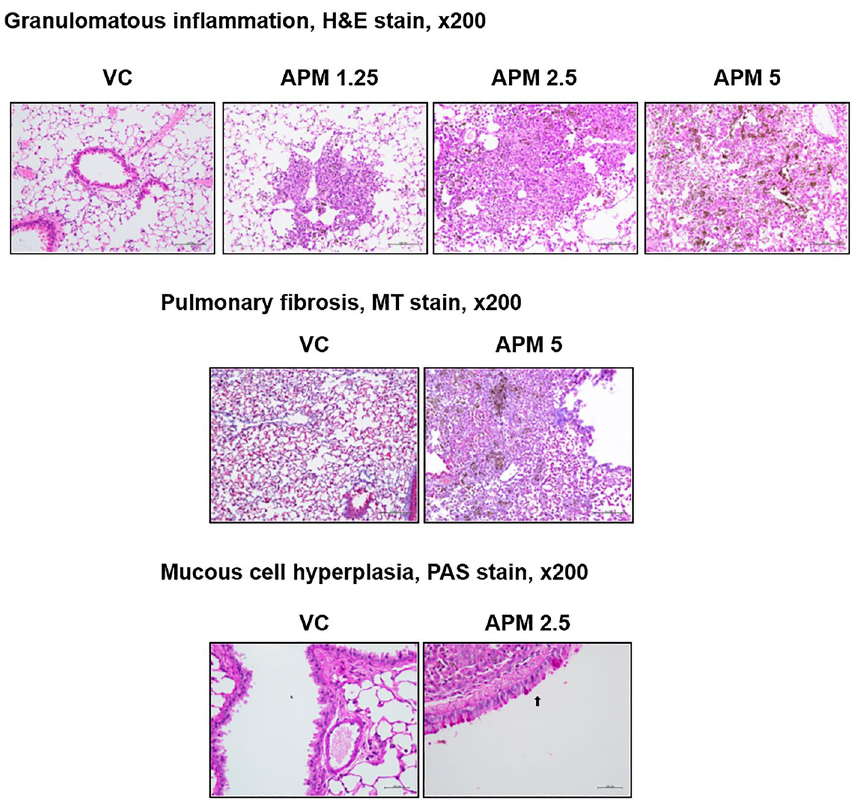
Figure 4. Representative MT- and PAS-stained slides of lungs obtained from mice instilled with vehicle and APM. The black arrow indicates mucous cell hyperplasia. MT Masson’s trichrome staining, PAS Periodic acid- Schiff, APM artificial particulate